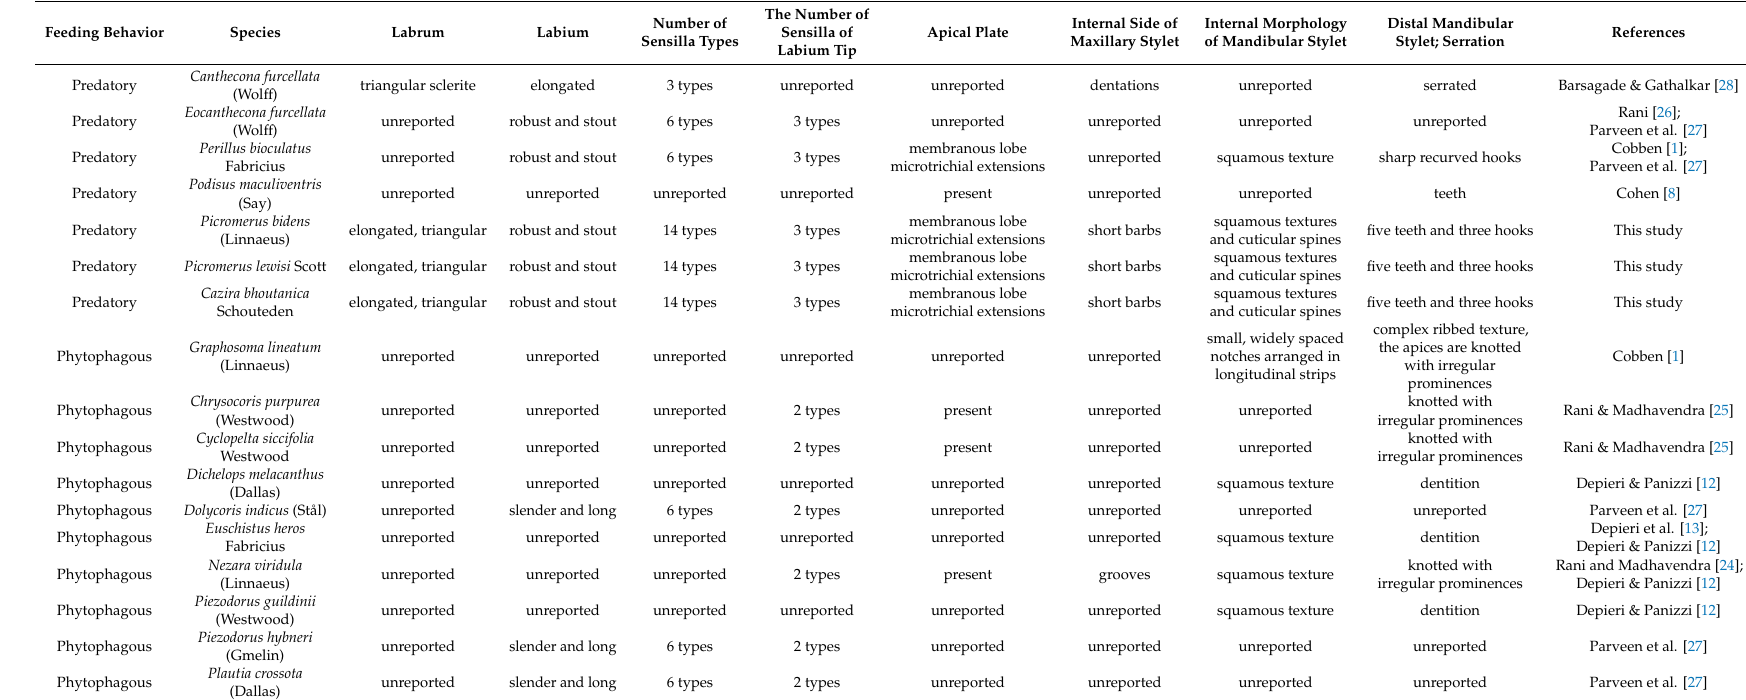
Table 4. Main features of mouthparts of stinkbugs